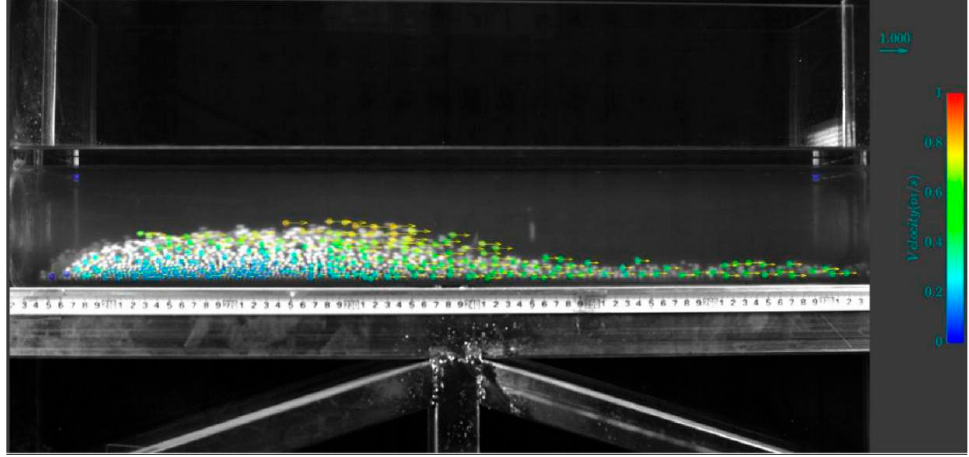
Figure 5. Operation interface of the PTV measurement system for pipeline fluid particle transporta- tion.